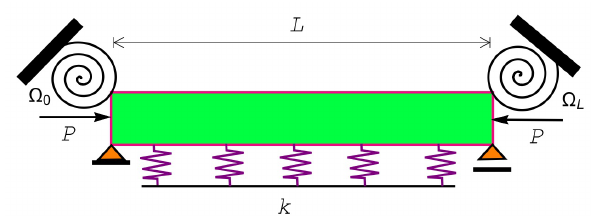
Figure 1: A simple supported microbar embedded in an elastic ma- trix with rotational